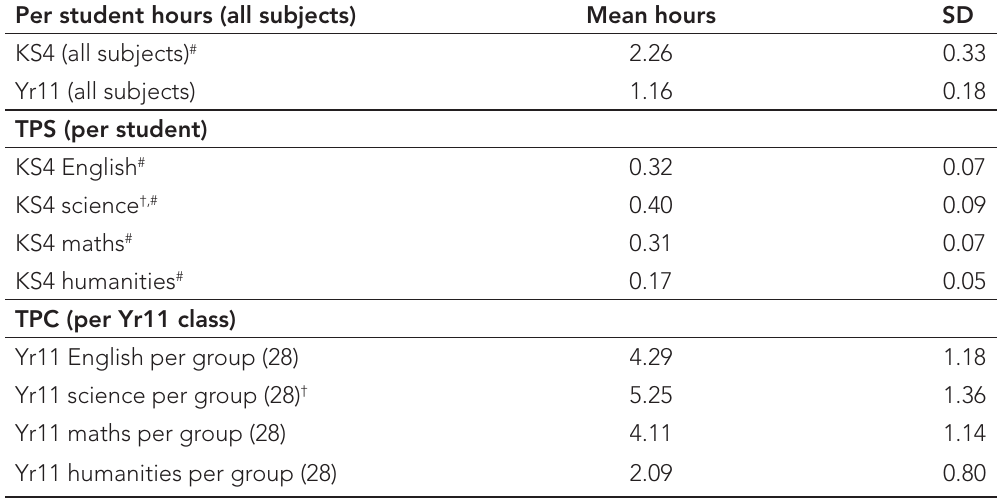
Table 1: Subject hours (2010–14) Per student hours (all